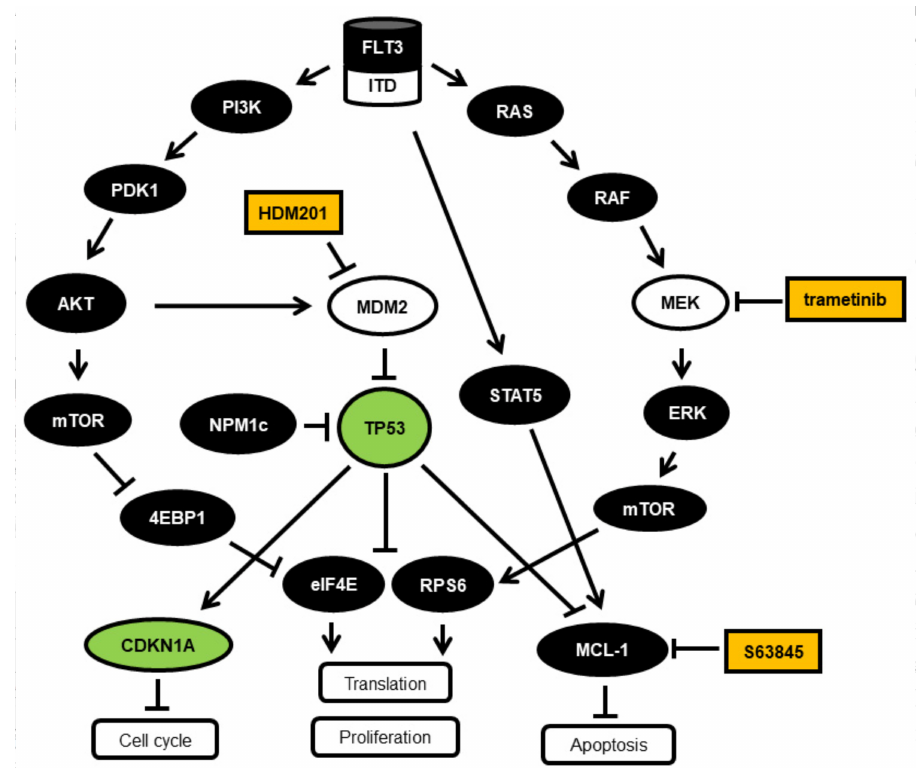
Figure 3. Schematic representation of the FLT3 signaling pathways and downstream e ff ects. The FLT3 growth factor receptor signaling is mediated by PI3K-PDK1-AKT and RAS-RAF-MEK-ERK, leading to cell growth and proliferation involving p53 inhibition and MCL1 gene induction. p53 function can be reactivated by HDM201 treatment, leading to inhibition of MCL1 gene expression. MCL1 function can be blocked by S63845. FLT3-ITD is a constitutively active growth factor receptor signaling via PI3K-AKT [8], via RAS-MEK-ERK [19], and via STAT5 [20], leading to cell growth and proliferation via p53 inhibition and MCL1